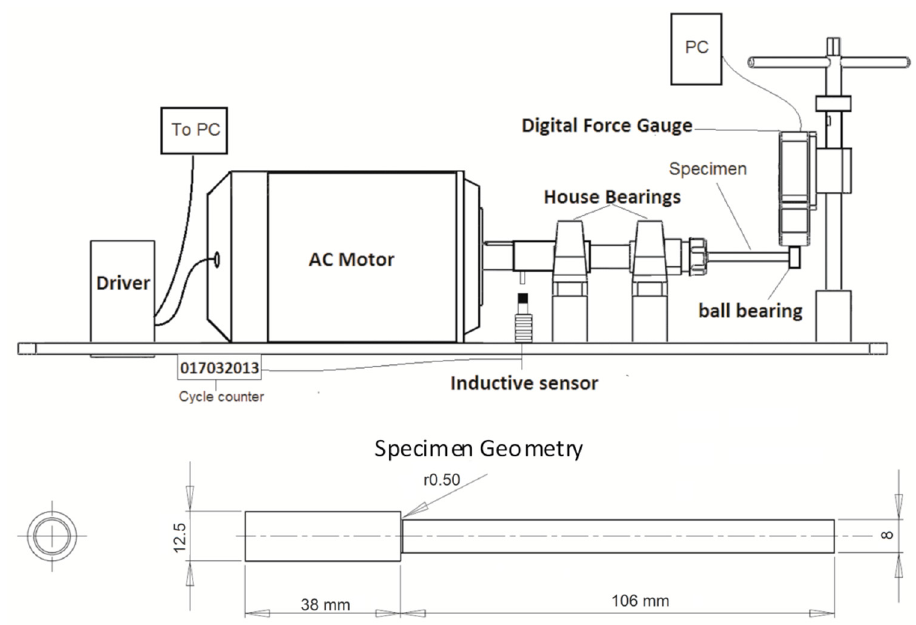
Figure 1. Schematic view of the cantilever rotating-bending fatigue (RBF) testing machine and specimen with a sharp notch.